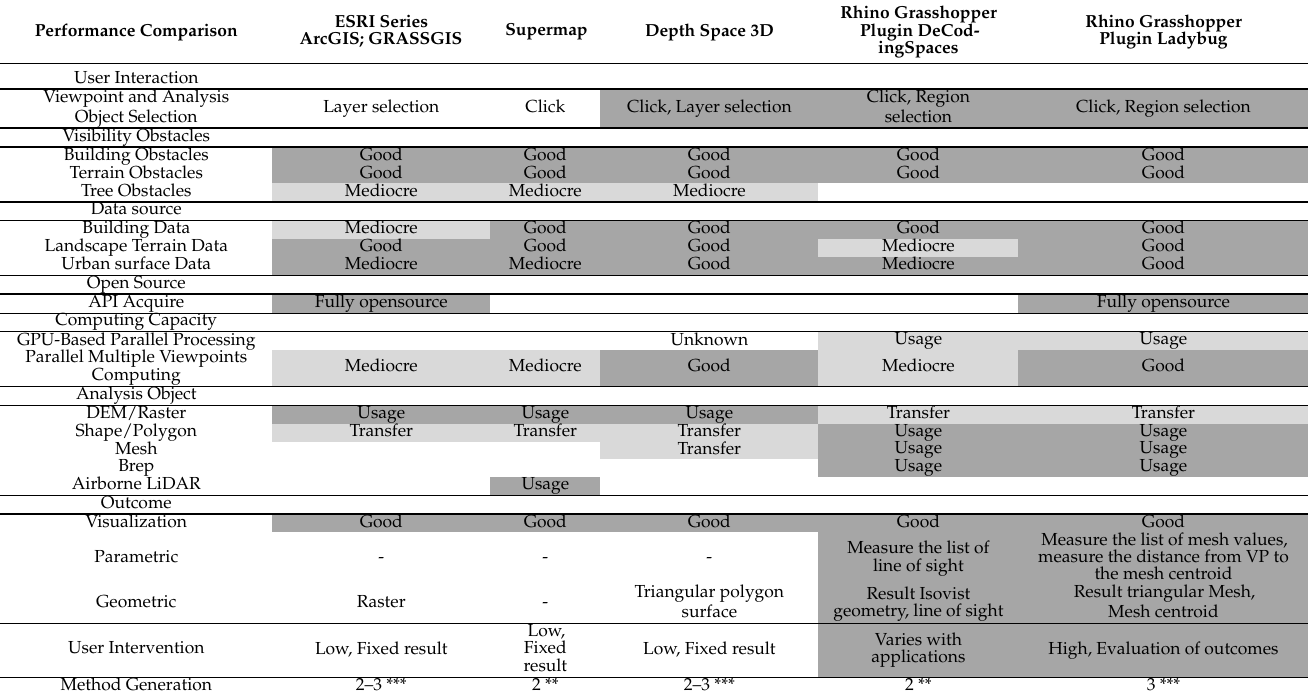
Table 3. Comparison of the mainstream tools for visibility analysis. The color highlight can better illustrate the performance level, with light grey is mediocre, dark grey is good, and white is